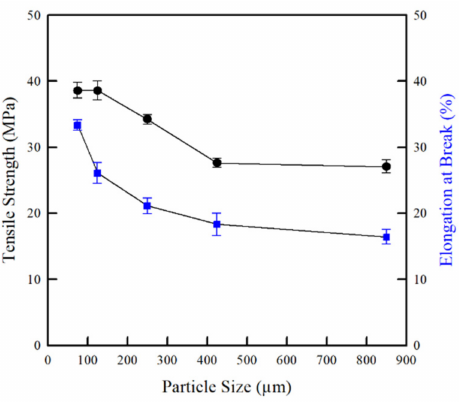
Figure 7. Effect of chitosan particle sizes on tensile strength and elongation of CMCh